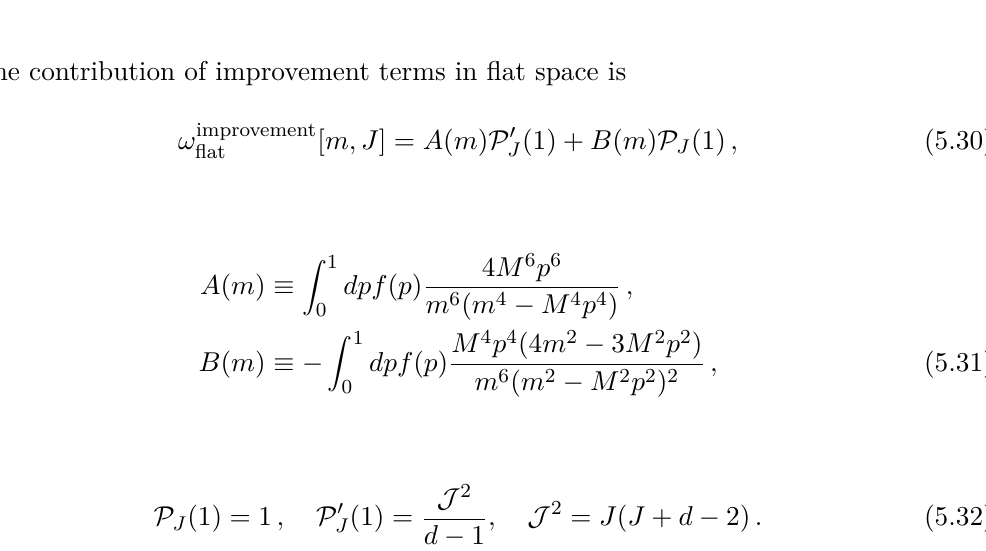
Figure 14. A cartoon of the regions used in the proof of positivity of ω AdS . In the blue-shaded region ω improvement dominates; in the red-shaded region ω unimproved dominates; in the purple overlap AdS AdS they are comparable. The gray-hatched region is the bulk-point regime, where positivity follows from agreement with ω . To establish positivity of ω , we will show positivity of ω improvement in flat AdS AdS the region β (cid:29) 1 /M bounded by the solid blue lines, and positivity of ω unimproved in Regge region AdS m (cid:29) M bounded by the solid red